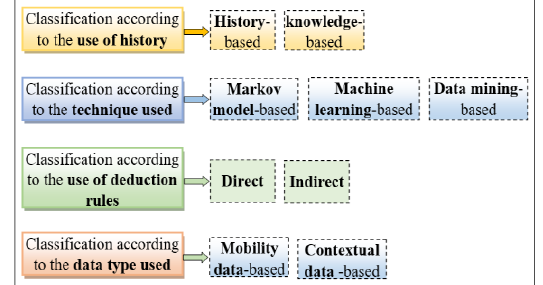
Figure 4 . Mobility prediction